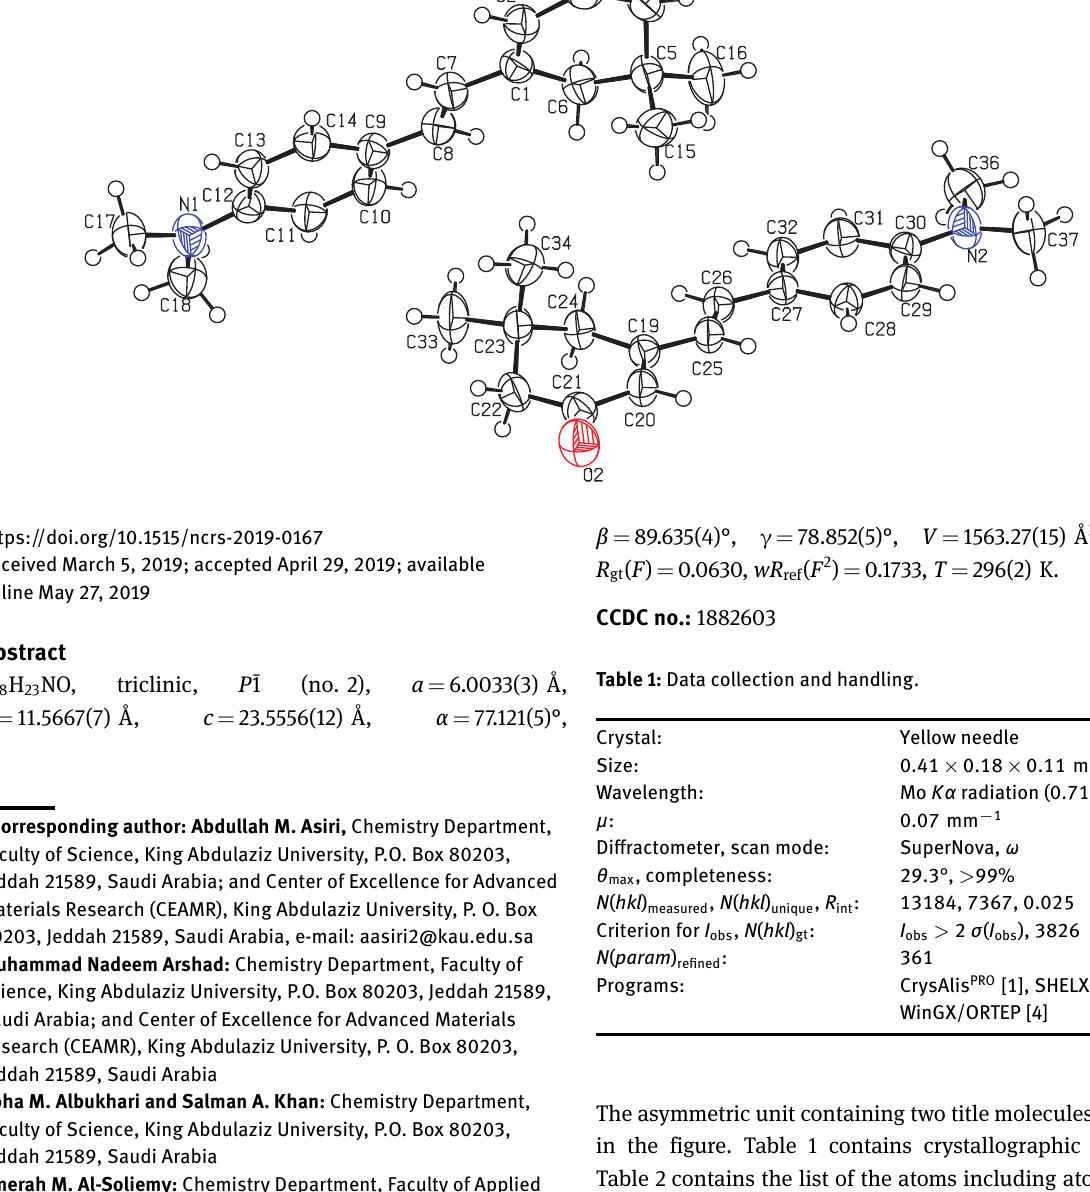
The asymmetric unit containing two title molecules is shown in the figure. Table 1 contains crystallographic data and Table 2 contains the list of the atoms including atomic coor- dinates and displacement